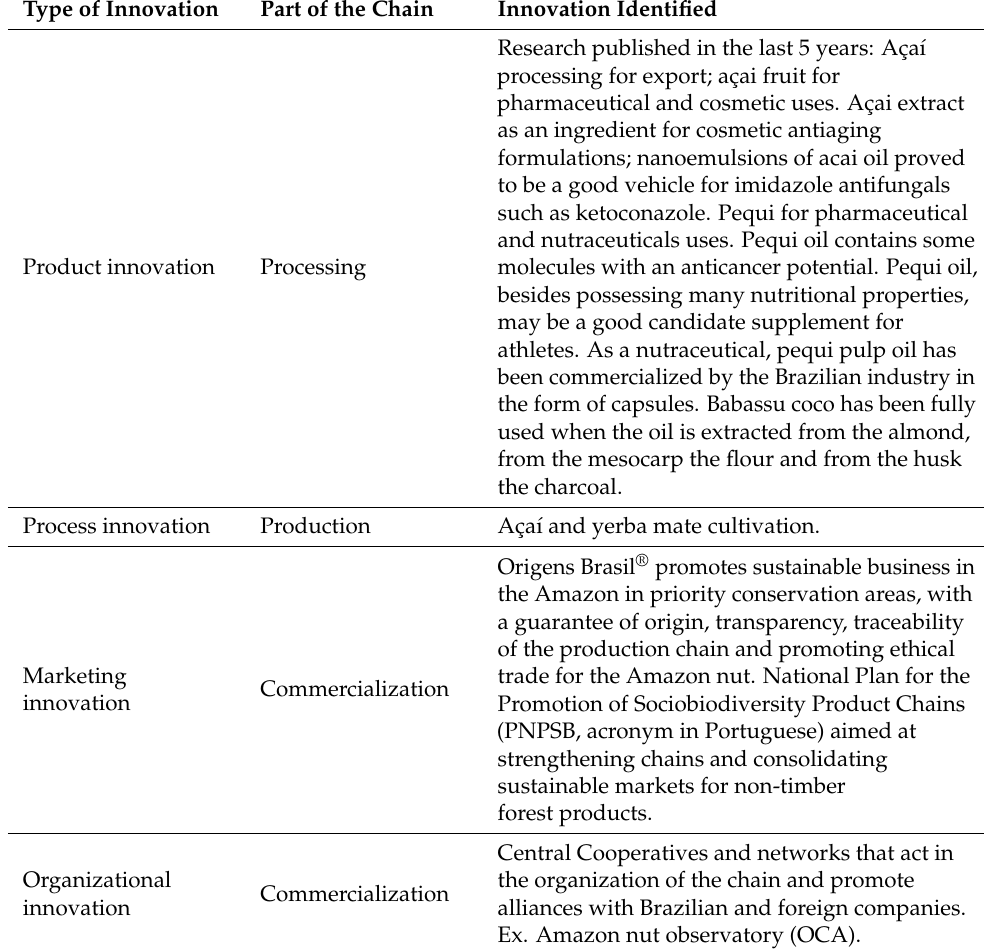
Table 3. Innovations identified by type of